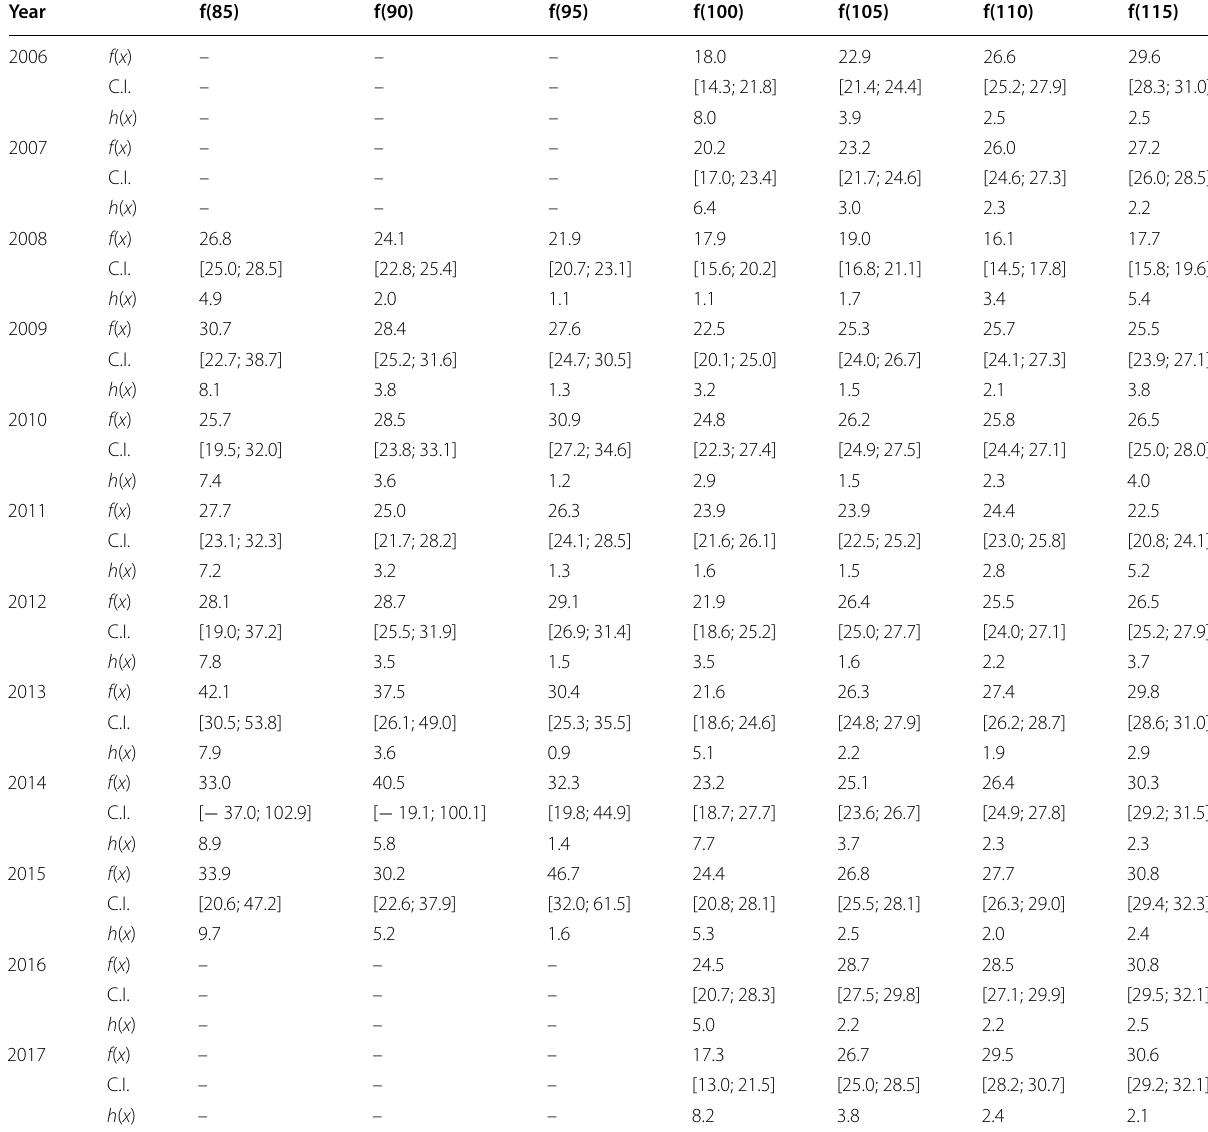
Table 4 Local linear regression: Share of Equity Assets Related to the Funding